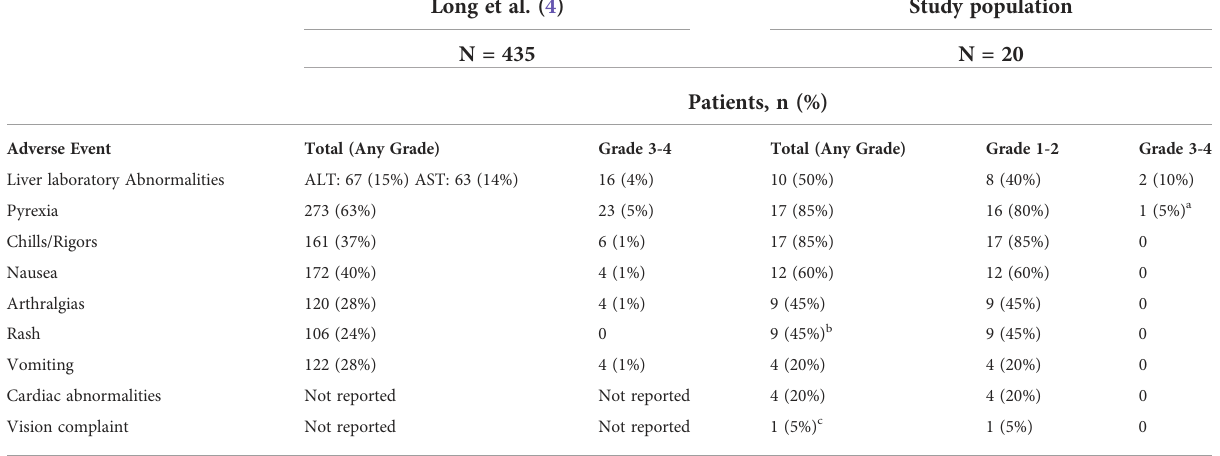
TABLE 2 Select adverse